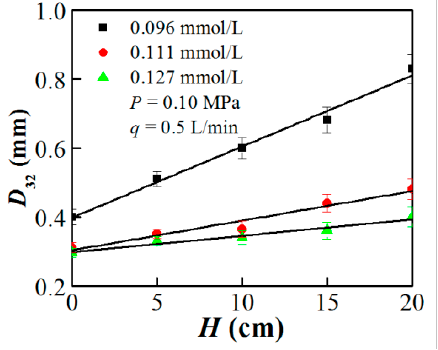
Figure 12. D 32 as a function of sampling location ( H ).